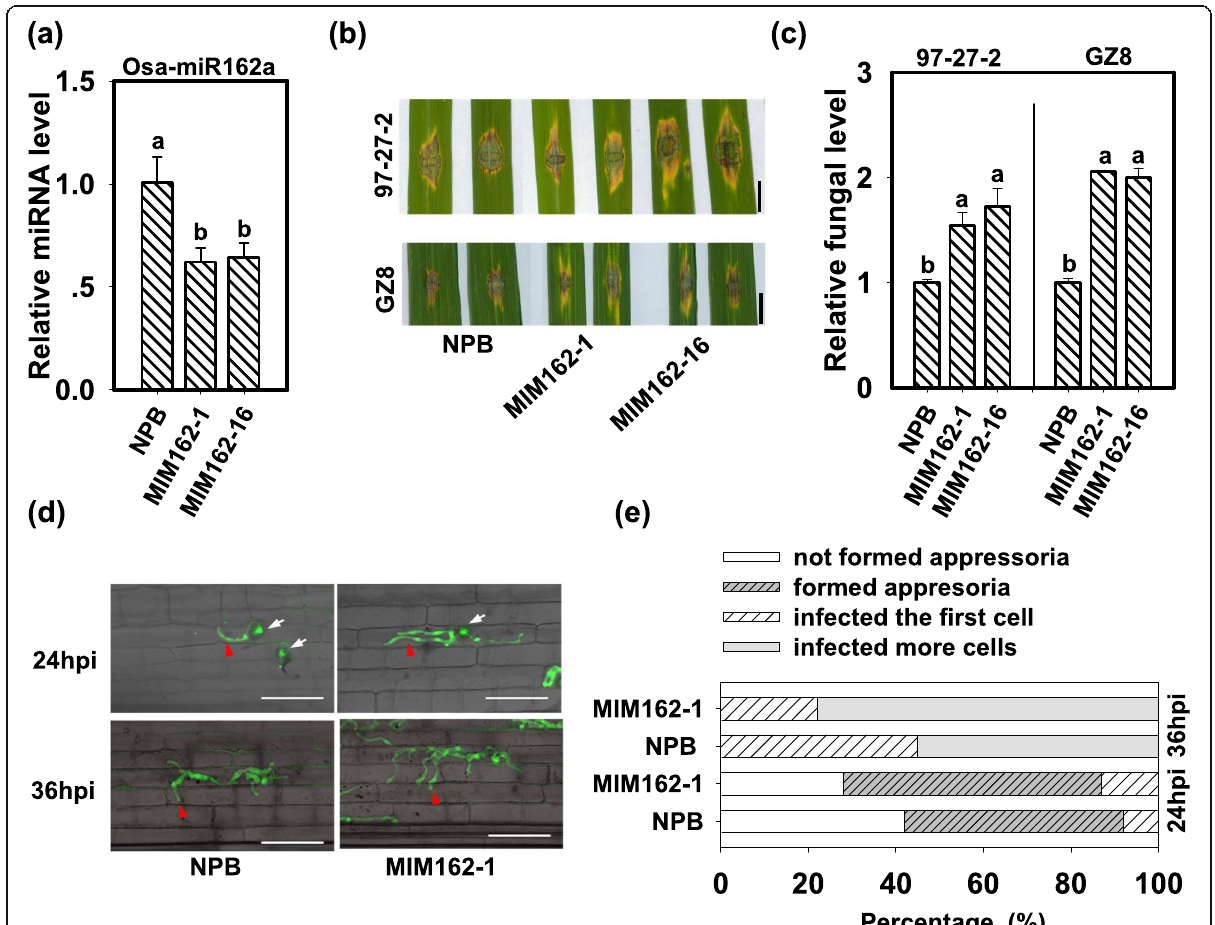
Fig. 4 Expression of a target mimic of Osa-miR162a (MIM162) enhances rice susceptibility to Magnaporthe oryzae . a Accumulation of Osa- miR162a in wild type (Nipponbare, NPB) and MIM162. Total RNA was used for reverse-transcription (RT) with an Osa-miR162 specific stem-loop RT primers (Additional file 4: Table S1), and the RT product was subsequently used as a template for quantitative polymerase chain reaction (q-PCR). snRNA U6 served as an internal reference. b Blast disease phenotypes on leaves of NPB and MIM162 at 5 days post-inoculation (dpi) of M. oryzae strain GZ8 and 97 – 27-2. Bar = 5 mm. c Quantification analysis of fungal biomass in ( b ). The relative fungal biomass was determined by detecting the DNA levels of the M. oryzae Pot2 gene against the rice Ubiquitin DNA levels. d Invasion process of GZ8 at 24 and 36 h post-inoculation (hpi) on sheath cells of the indicated lines. Bars = 25 μ m. The white arrows indicate appressoria formed from conidia, and the red arrowheads indicate invasive hypha in rice sheath cells. e Quantification analysis on infection process. Over 200 conidia in each line were analyzed. For ( a ) and ( c ), Error bars indicate SD (n = 3). Different letters above the bars indicate significant differences ( P < 0.05) as determined by One-way ANOVA analysis. Similar results were obtained in at least two independent